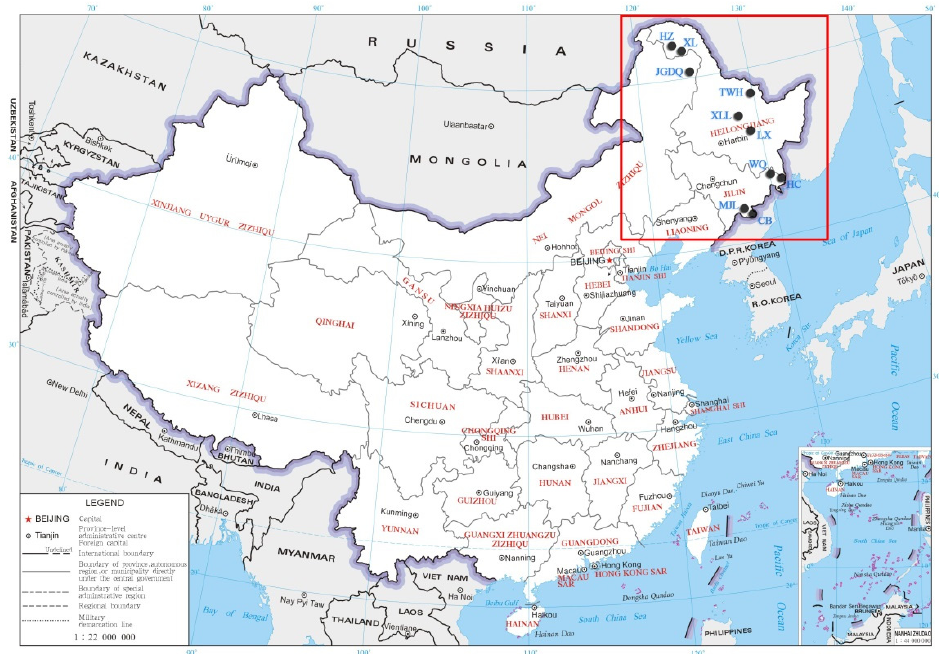
Figure 1. Locations of ten C. arbutifolia (Pall.) A. Skv. populations in Northeast China. Table 1. Details of provenances.